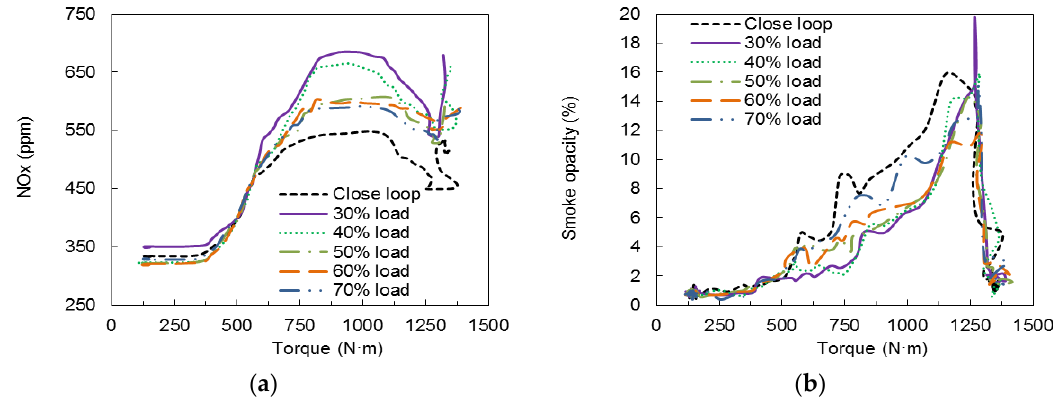
Figure 12. Effect of SSRP strategy on transient performance: ( a ) NOx; ( b ) smoke opacity.